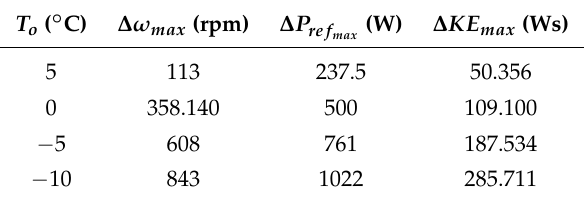
Table 4. Determined power setpoint for different outdoor